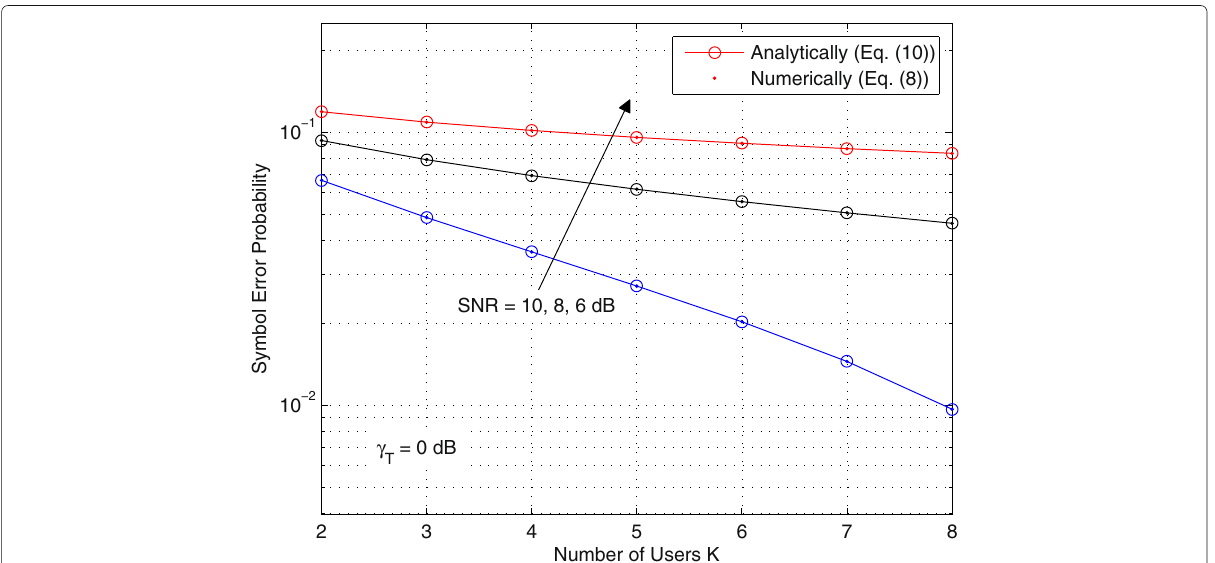
Fig. 8 Symbol error probability vs number of users of cognitive AF relay network with MUSwiD user selection scheme for different values of I p / N 0 and (cid:3) s,p = 20, and (cid:3) s,r = 0.8, (cid:3) r,p = 0.6, (cid:3) r, k = 0.8 for k = 1, ... ,8